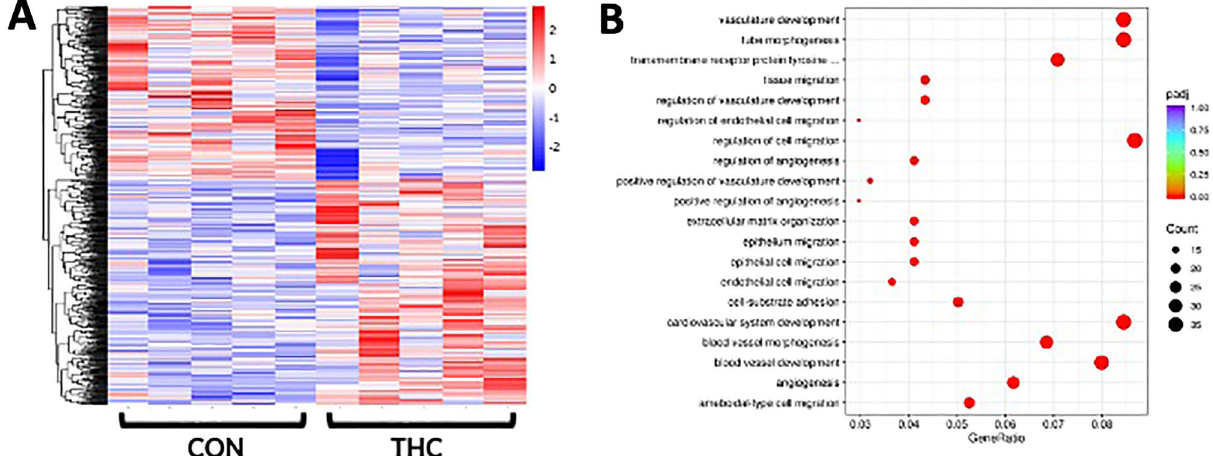
Figure 5. ( A ) Bulk placental RNA-sequencing suggests prenatal THC exposure is associated with a clear gene expression signature. RNA-sequencing of rhesus macaque placental tissue at gestational day 155. Heatmap of hierarchical clustering analysis of differentially expressed genes of control (left, n = 5) and THC-exposed (right, n = 5) placental samples. ( B) RNA seq pathway analysis. Top significant terms in the Gene Ontology (GO) enrichment analysis of control versus THC-exposed placentas suggest prenatal THC exposure is associated with dysregulated placental vascular development and intracellular signaling, involved in